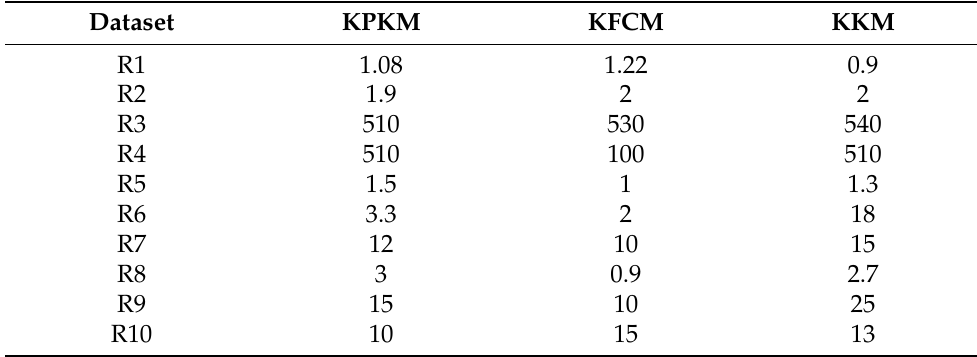
Table 3. Parameter σ selected for kernel clustering